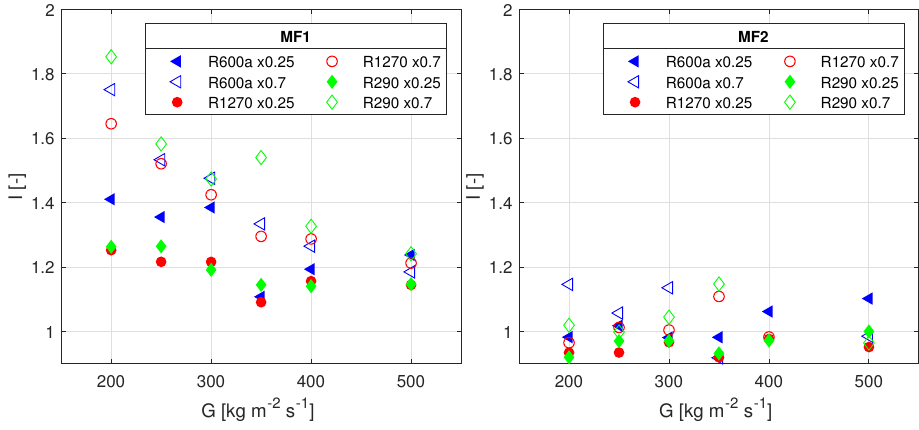
Figure 12. Effect of mass flux on efficiency index, I , for MF tubes at x = 0.25 and x = 0.7. Furthermore, δ 30 is defined as the percentage of the predicted values having less than 30% deviation from the experimental data. The correlations were chosen on the basis of the database they were developed with, such as Macdonald and Garimella [9] that considered condensation of hydrocarbons, or Xu and Fang [30] that uses Weber number to take into account surface tension that is important in compact tubes. Table 4 summarizes the results of comparison for both of the fluids in smooth tube. Table 4. Comparison between experimental results and correlations for HTC and pressure drop in smooth tube, with best performing correlations in